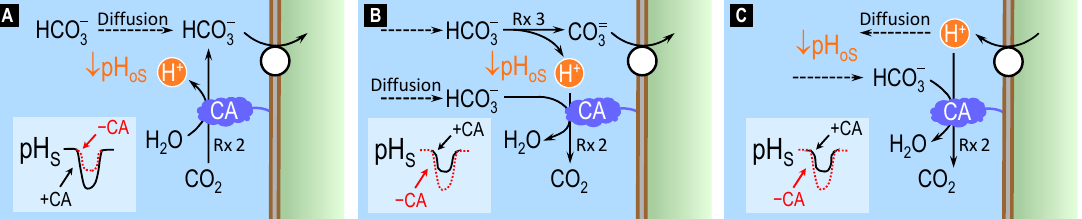
Figure 4. Theory of bicarbonate influx vs. carbonate influx vs. proton efflux across cell membranes. ( A ) The entry of HCO 3 − into the cell leads to the production of H + (i.e., a decrease in pH oS ; inset, lower left corner: solid black trace) via the CA-catalyzed reaction CO 2 + H 2 O → HCO 3 − + H + (indicated as ‘Rx 2’) at the outer surface (oS) of the cell membrane. Blocking CA (i.e., applying a CA inhibitor) reduces H + production (i.e., the decrease in pH oS ; dashed red trace). ( B ) The entry of CO 32 − into the cell leads to the production of H + (i.e., a decrease in pH oS ; solid black trace) via the reaction HCO 3 − → CO 32 − + H + (indicated as ‘Rx 3’) at the outer surface of the cell membrane. Blocking CA (i.e., applying a CA inhibitor) reduces H + consumption by ‘Rx 2’ (i.e., increases the fall in pH oS ; dashed red trace). ( C ) The exit of H + from the cell leads to an immediate increase in [H + ] oS (i.e., a decrease in pH oS ; solid black trace) which is mitigated by the CA-catalyzed reaction HCO 3 − + H + → CO 2 + H 2 O at the outer surface of the cell membrane. Blocking CA (i.e., applying a CA inhibitor) reduces H + consumption by ‘Rx 2’ (i.e., increases the fall in pH os ; dashed red trace). In model ( C ), the effect of blocking CA is the same as in model ( B ). Rx = reaction; the number following the abbreviation ‘Rx’ indicates the numbering of the reaction in the main text. CA = carbonic